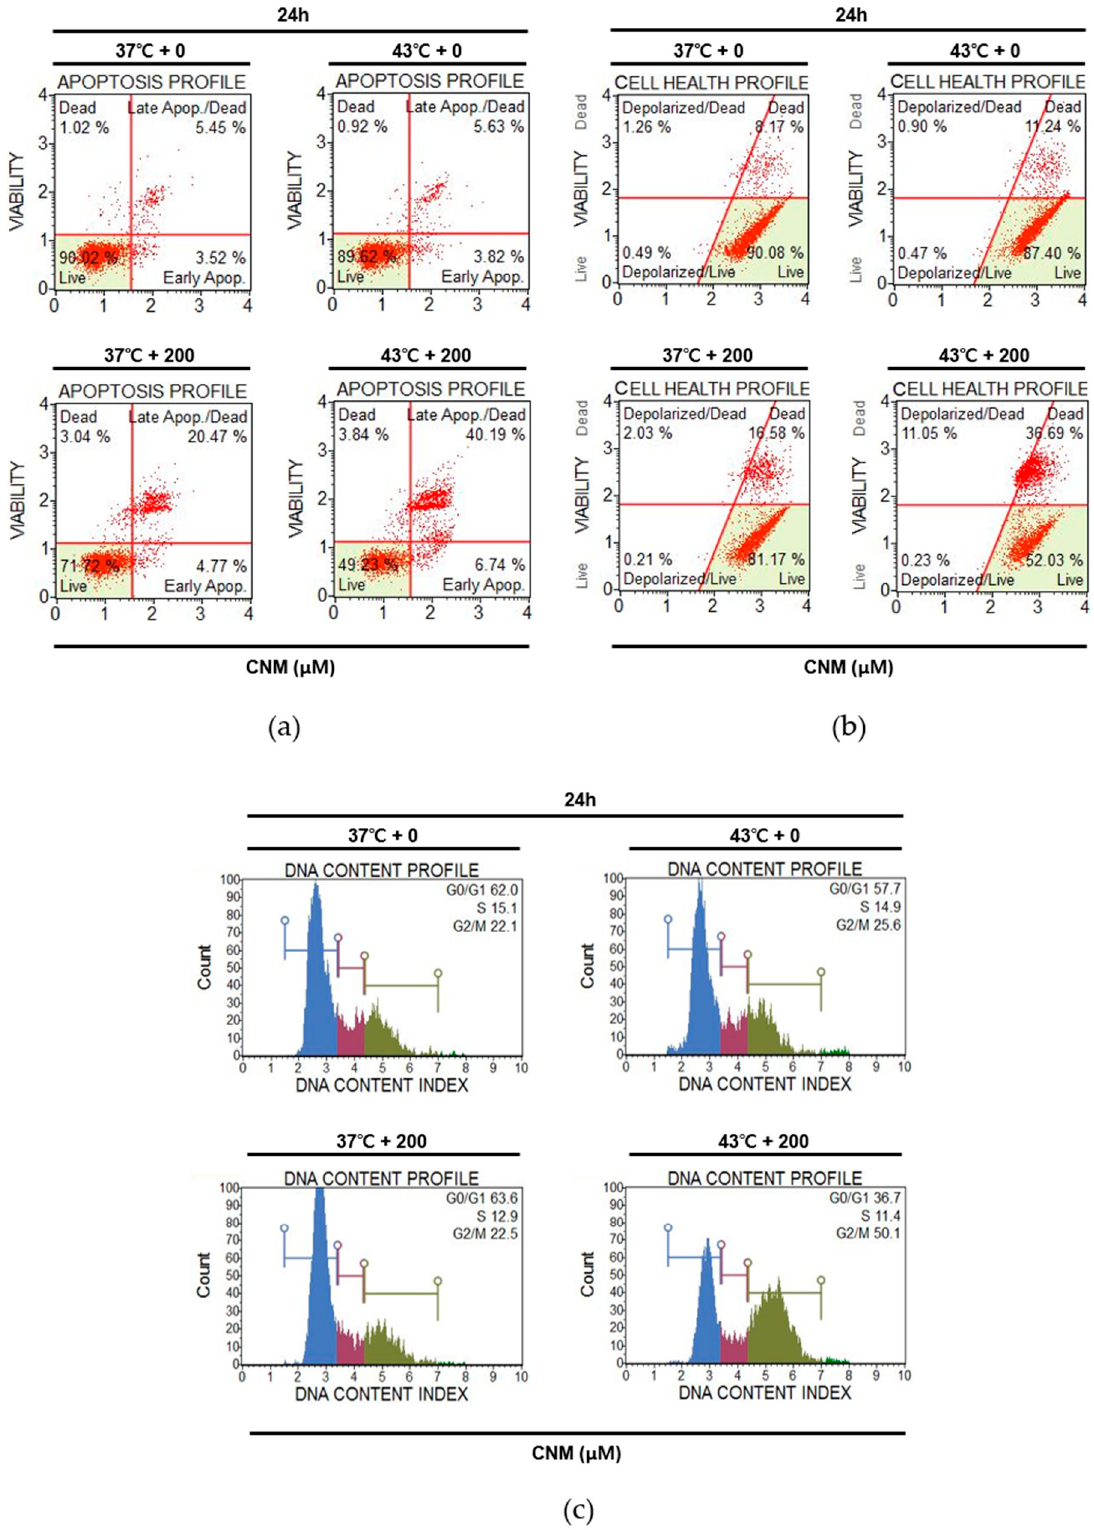
Figure 4. Effect of CNM and hyperthermia combination therapy on the apoptosis profile, cell health profile and cell cycle profile in A549 cells. A549 cells were treated with CNM (0, 200 μ M) with or without hyperthermia and incubated for 2 h. Annexin V and 7-AAD staining was used to detect apoptosis and then analyzed by a flow cytometer. Flow cytometry analysis on ( a ) apoptosis profile, ( b ) mitochondrial membrane potential profile and ( c ) cell cycle profile was performed.